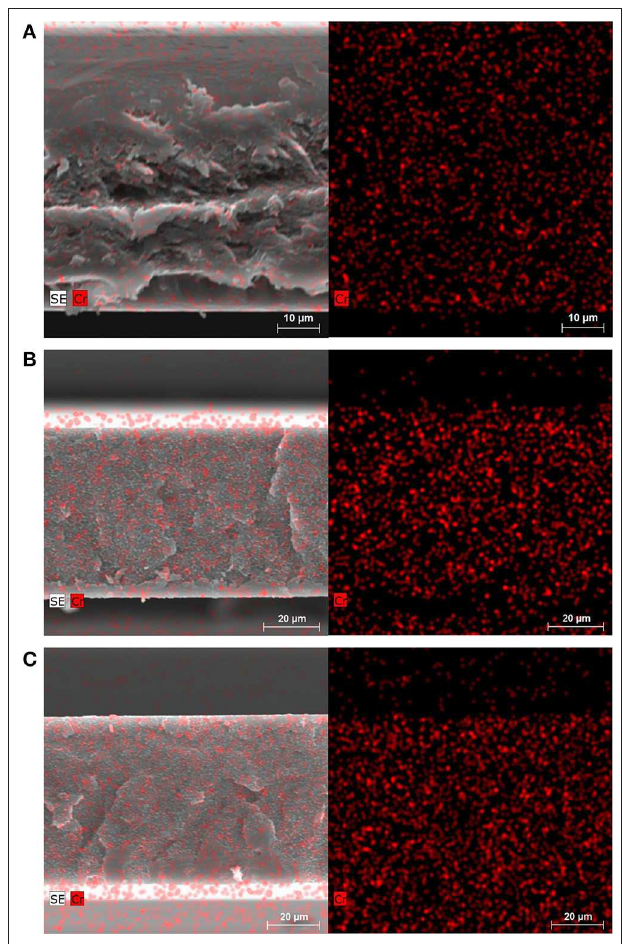
FIGURE 6 | SEM/EDX images of the cross-section of nanoMIL-101Cr@Matrimid membrane with 8 wt.% MOF (A) , 16 wt.% MOF (B) , and 24 wt.% MOF (C) . Left: SEM/EDX images superimposed. Right: EDX element mapping (Cr = red). The bottom of the cross-sections in the image corresponds to the bottom of the membrane when casted. The cross-section of a pure Matrimid membrane is shown in Figure S25B . Dark and light areas around cross-section of membranes depend on mounting on SEM sample holder (see Figure S2